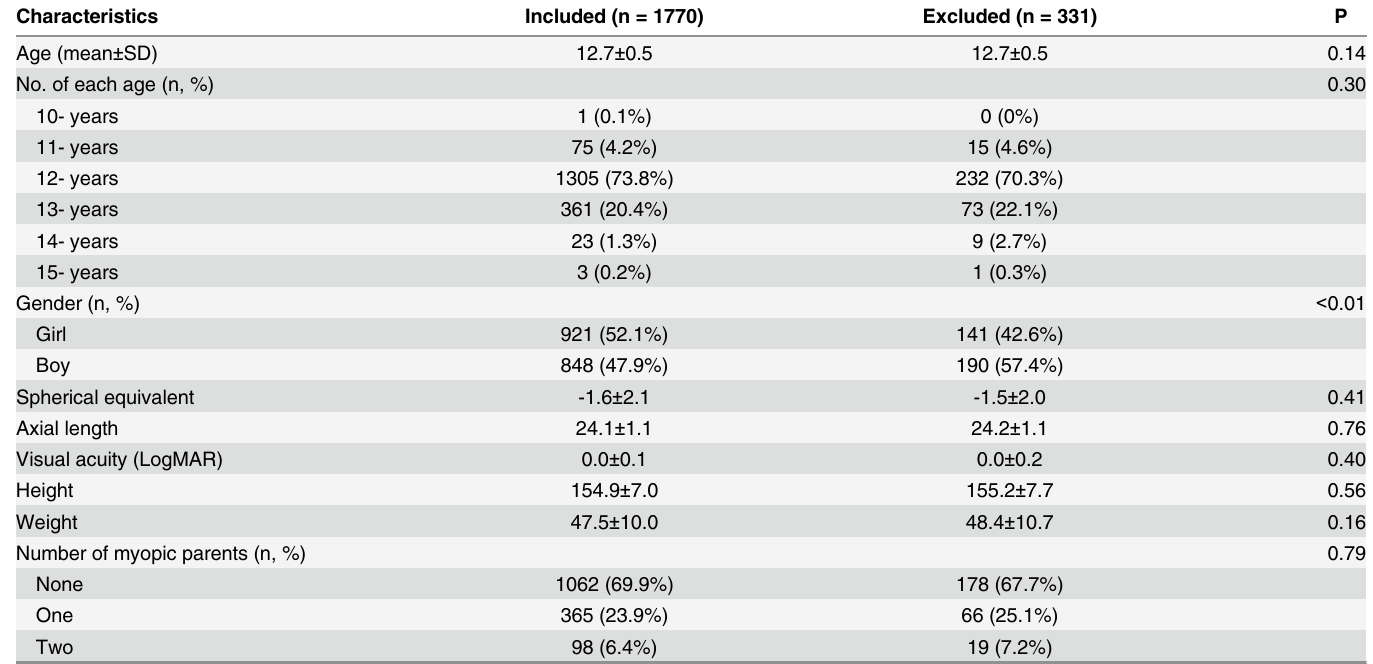
Table 1. Comparison of the participants that were included vs. excluded from the study. Characteristics